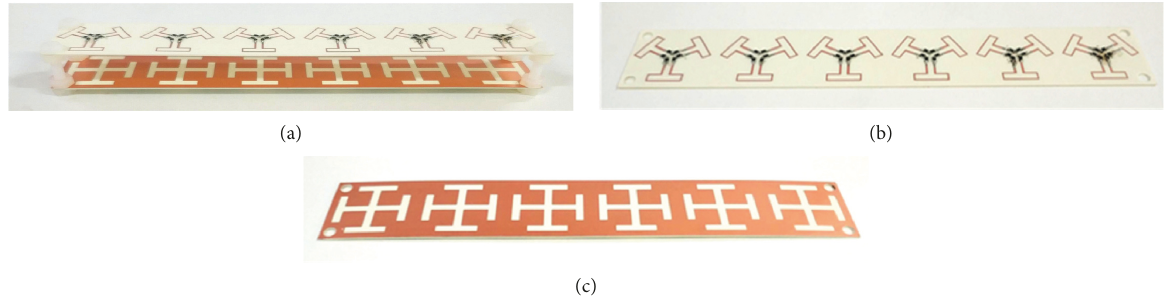
Figure 9: Photos of the fabricated rasorber. (a) Assembled structure with plastic screws. (b) Resistive layer on the top (c) Bandpass layer at the bottom.